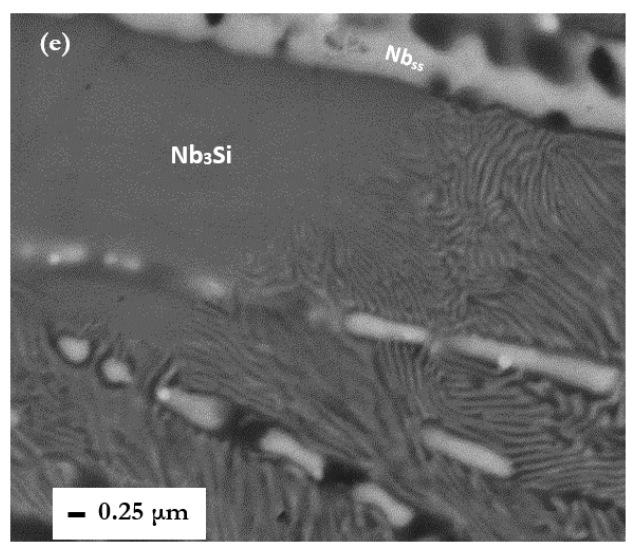
Figure 1. As cast alloy CM1 ( a ) CM1-10g button, ( b ) CM1-6mm (bulk) and ( c – e ) CM1-8mm suctions cast bars, ( c ) bulk, ( d ) and ( e ) from area of high cooling rate and 18.6 < Si < 19.2 at.%. Rectangles show lamellar microstructures. The lamellar microstructure resulting from the eutectoid transformation of Nb3Si is shown in the right hand side of ( e ).